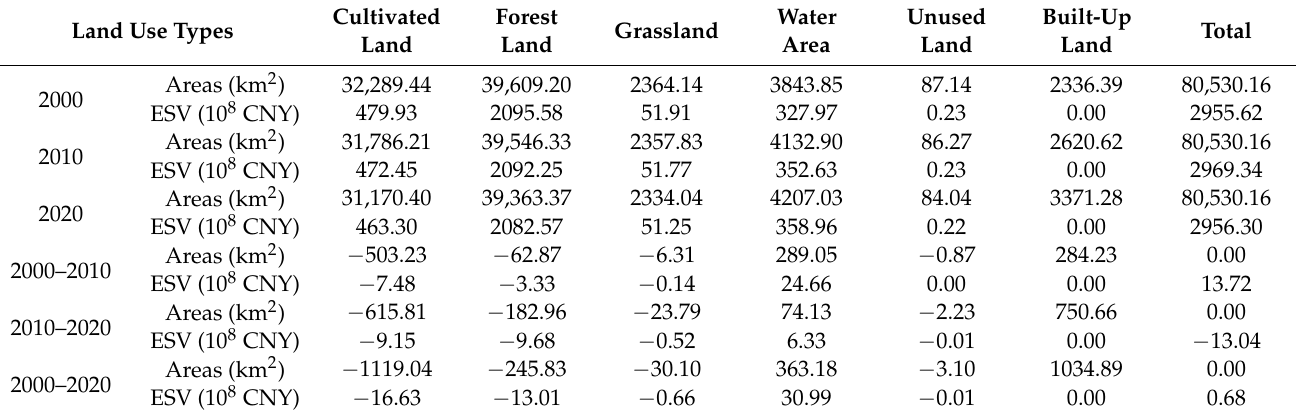
Table 4. ESV of different land use types in the HRB of Hubei Province from 2000 to